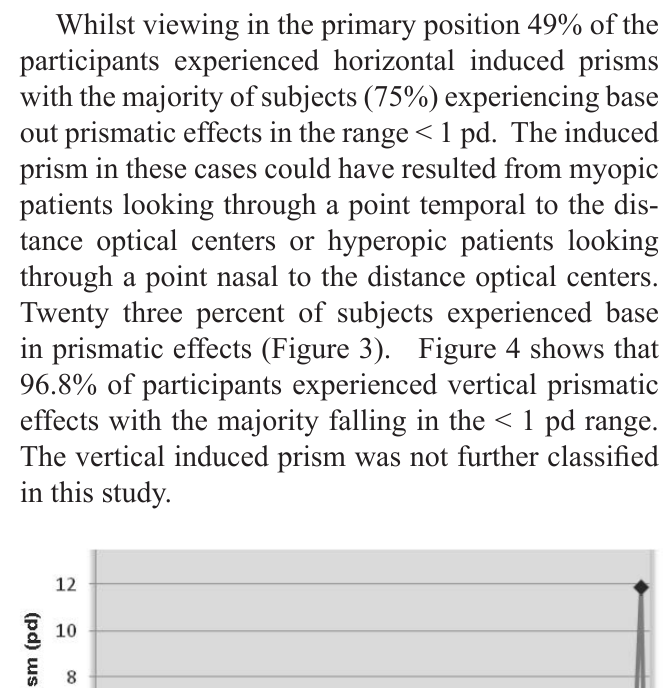
Figure 3 : showing the ranges of the induced BI and BO horizon- tal prismatic effects experienced by participants (ANSI = 0.75 Δ).